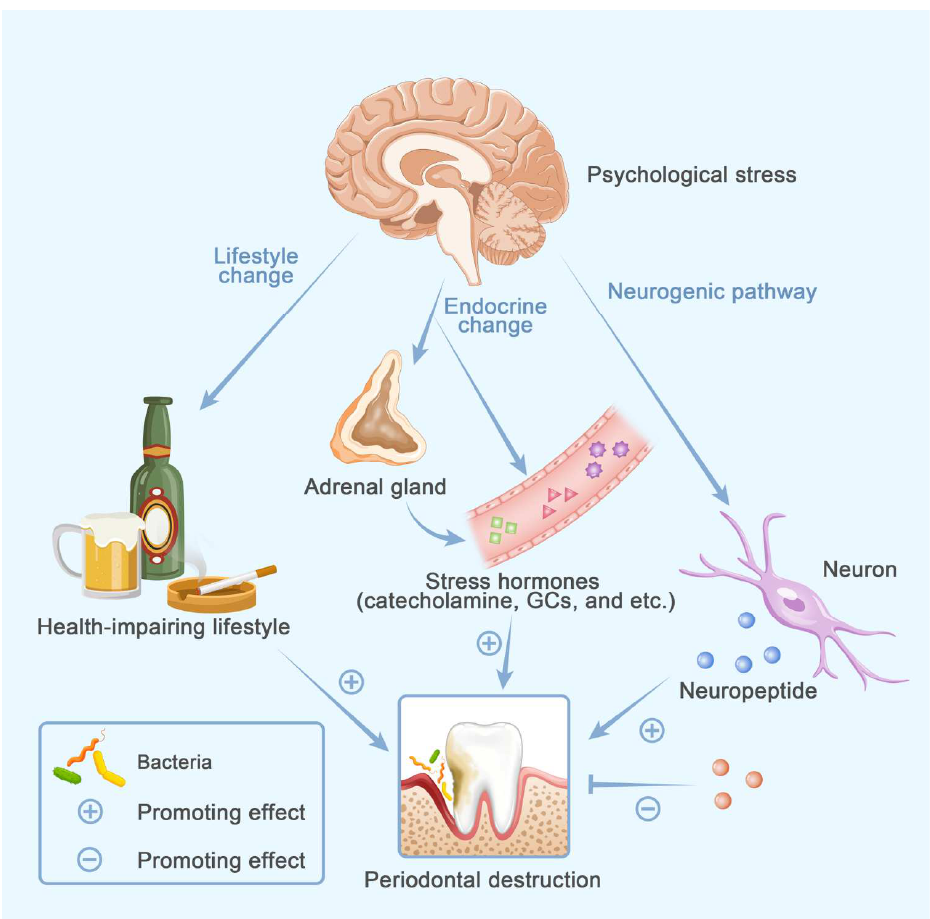
Figure 5. Impacts of psychological stress on periodontal status. Psychological stress affects periodontitis via three pathways, including lifestyle change, endocrine change and neurogenic pathway. Health-impairing lifestyles, such as smoking and alcohol consumption, exacerbate periodontitis-associated alveolar bone loss. Endocrine change mainly manifests as altered levels of stress hormones, such as GCs and catecholamine. GCs and catecholamine modulate bone remodeling and immuno-inflammatory response, adding to periodontal deterioration. Neuropeptides are the major effectors in the neurogenic pathway. Current evidence indicates the presence of both protective and harmful factors among neuropeptides. GCs, glucocorticoids.